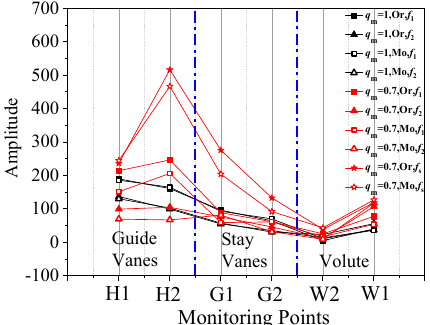
Figure 11. Comparison of main frequency amplitudes of pressure spectrum.